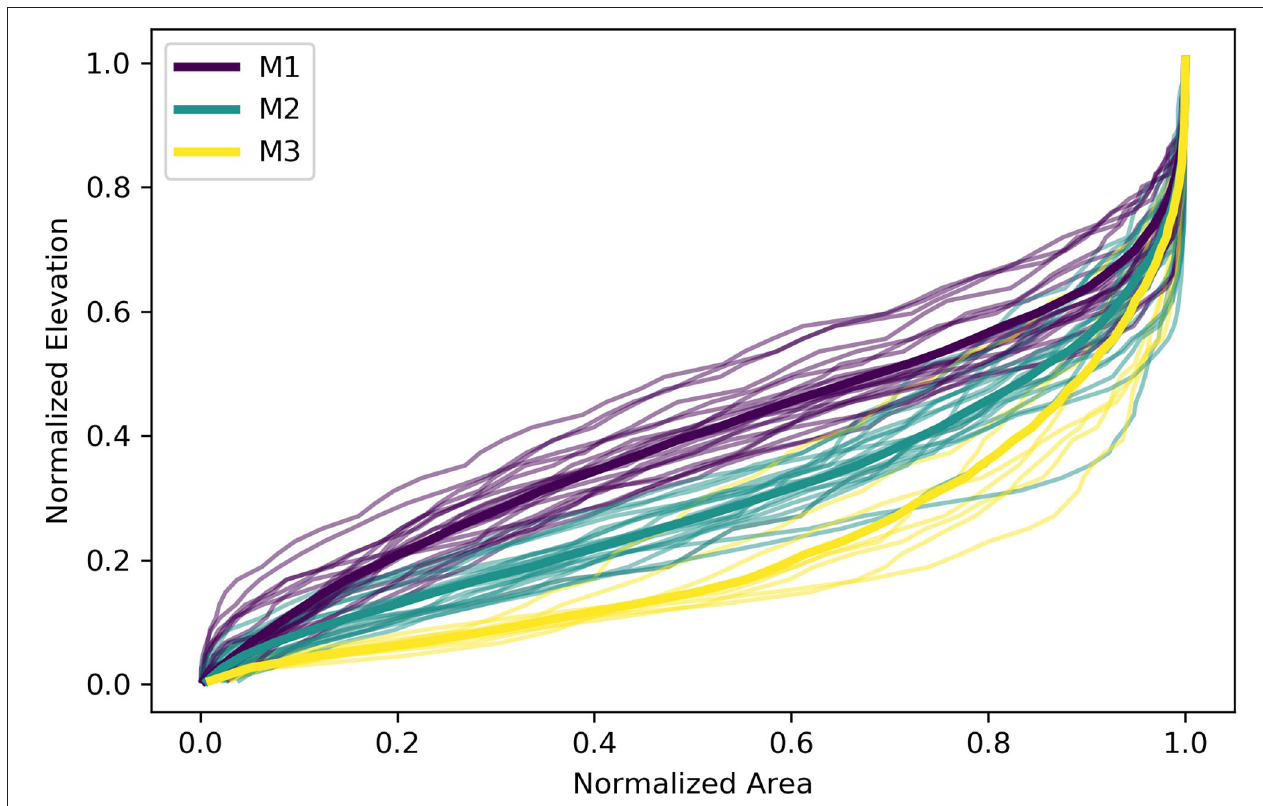
FIGURE 2 | Normalized hypsometries for 50 mountain basins shown in Figure 1 (thin lines), color coded by cluster type. Mean cluster hypsometries are given by bold lines.